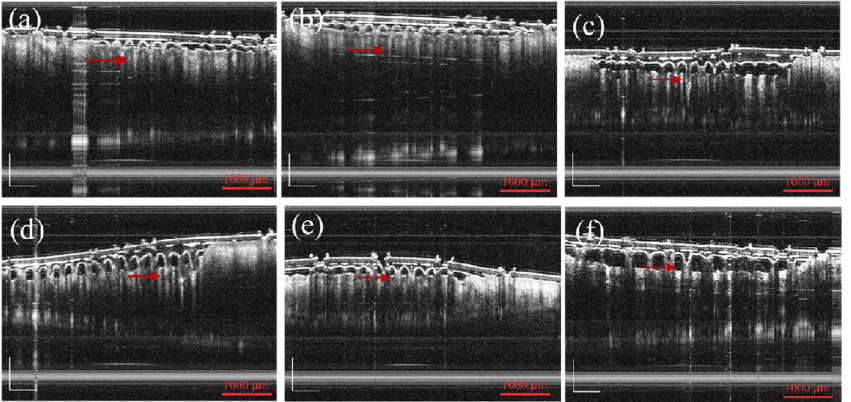
Figure 6. Optical coherence tomography images of MNs: ( a – f ) METH-treated Pro/MT/SF = 0/1/100, 10/1/100, 20/1/100, 30/1/100, and 50/1/100 (The red arrows indicate the MNs, scale bar is 1000 μ m) .